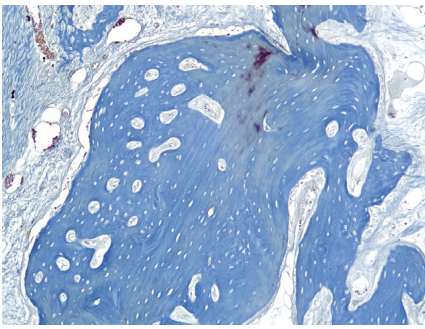
Figure 16: Histotopogram of the rabbit’s mandible cross section 4 weeks after the formation of a bone defect and introduction of a suspension of calcium hydroxide with nanodispersed cerium dioxide.